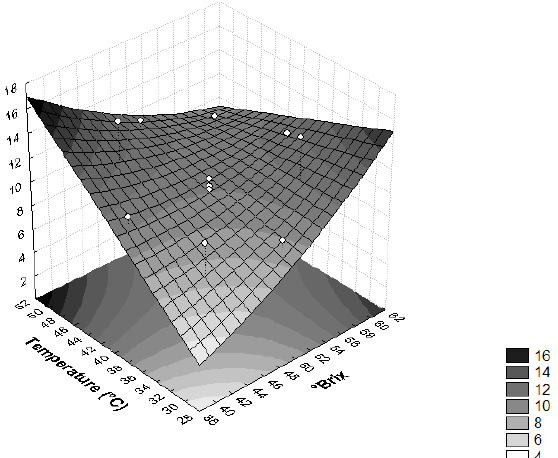
Figure 3. Surface response for solid gain (SG) as a function of the concentration of sucrose solution ( ◦ Brix) and temperature ( ◦